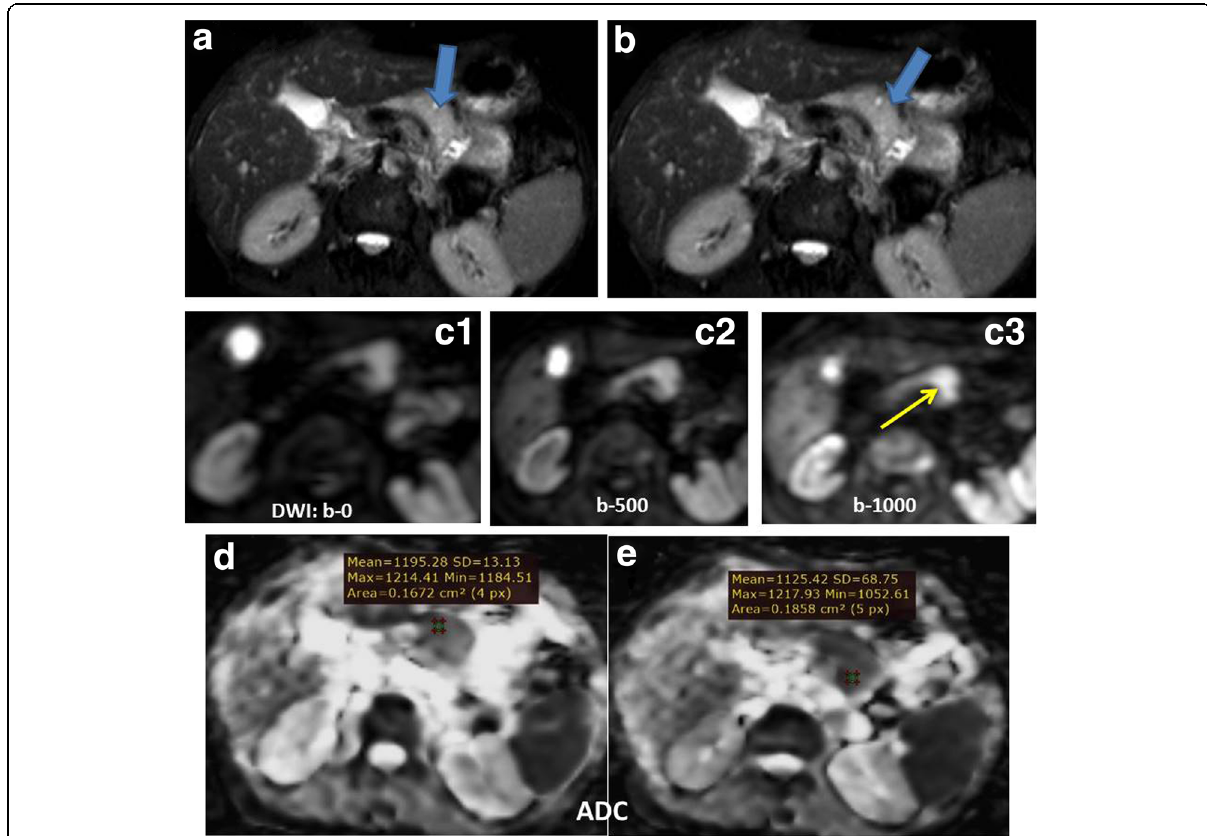
Fig. 5 A 70-year-old male patient presented with abdominal discomfort and pain. a , b Axial T2 fat saturation revealed just deformed contour of pancreatic body with no detectable abnormal signal lesions. c1 – c3 DWI at multiple b values (0, 500, and 1000 s/mm 2 ). The lesion appeared with increased restriction by elevating the b value (yellow arrow at c3 ). d , e The pancreatic lesion showed low signal at ADC map with low ADC value (1.1 × 10 − 3 mm 2 ). The lesion abuts the superior surface of the mesenteric vessels but not encase them (resectable